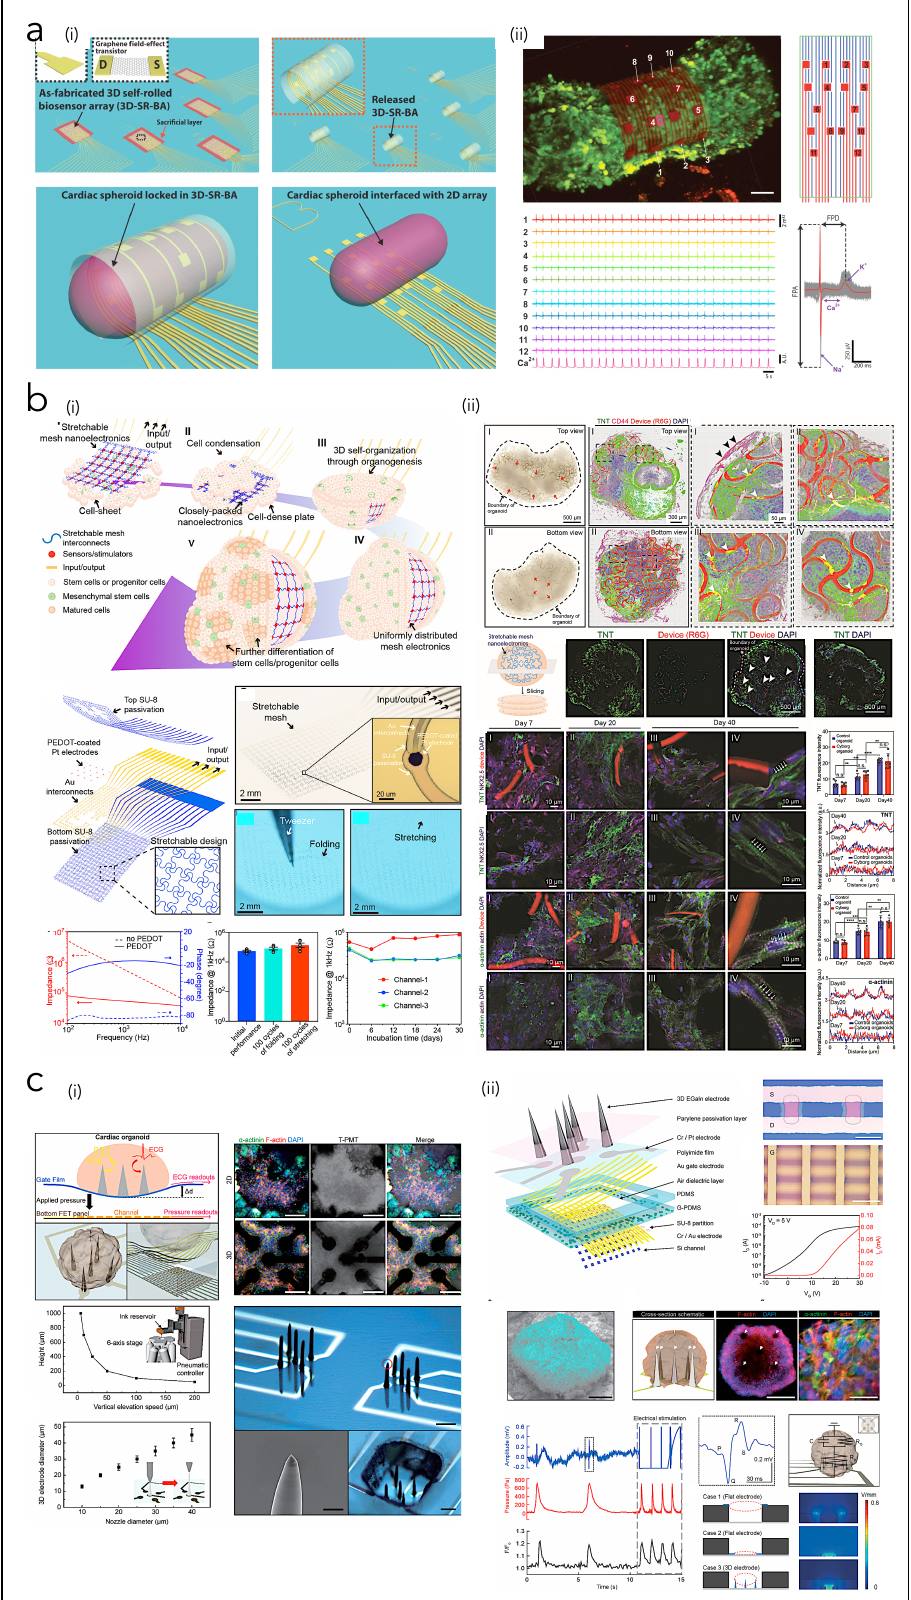
Figure 10. Bioelectronics integrated with cardiac organoids as in vitro cardiac models. ( a ) 3D self-rolled biosensor array (organ-on-e-chip) (i) for electrical interrogation of human embryonic